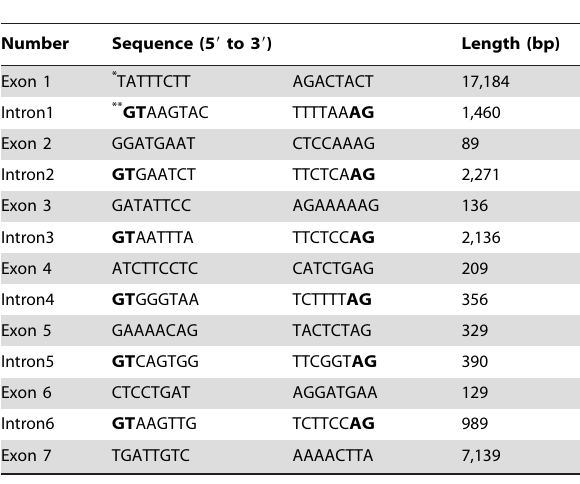
Table 1. Exons and introns information of Porcine XIST